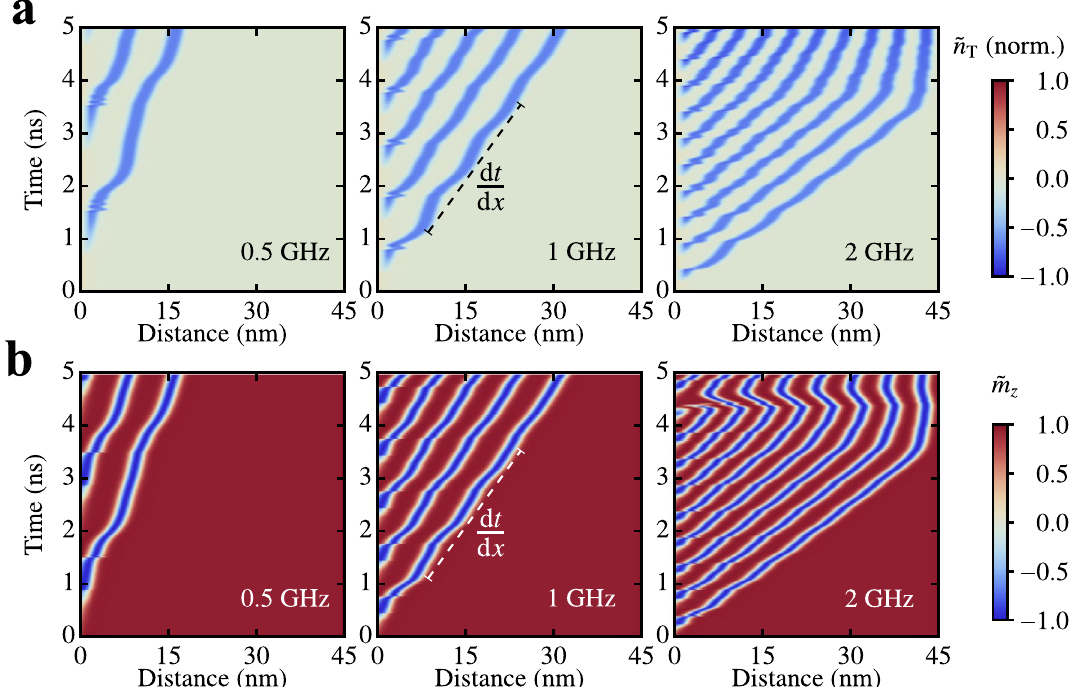
Figure 3. Skyrmion and domain wall steered by a continuously rotating effective magnetic field localized at the sample edge. Path-time diagrams of the skyrmion ( a ) and DW ( b ) propagation for ν = 0.5, 1, 2 GHz, respectively (from left to right). Each horizontal line of pixels shows ( a ) the topological charge density or ( b ) the out-of-plane component of the magnetization, each averaged over cross sections of the nanostripe in ( ˜ n T ( x , t ) , ˜ m z ( x , t ) ). The inverse mean slopes of the curves give the velocities of the quasiparticles. System size: 200 × 30 × 1 c 3 , with material parameters corresponding to Pd/Fe/Ir(111); c = 0.233